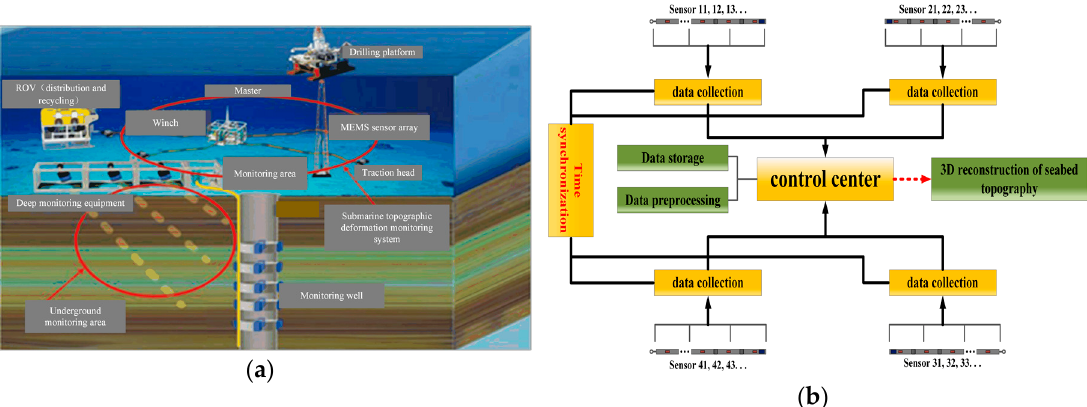
Figure 2. ( a ) MEMS sensor array submarine layout; ( b ) Data synchronous acquisition system diagram.